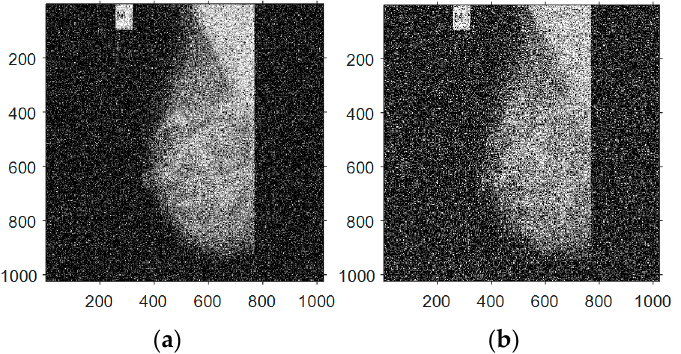
Figure 15. Mammogram attacked with Gaussian white noise of zero mean and variance of ( a ) 0.10 and ( b ) 0.02.